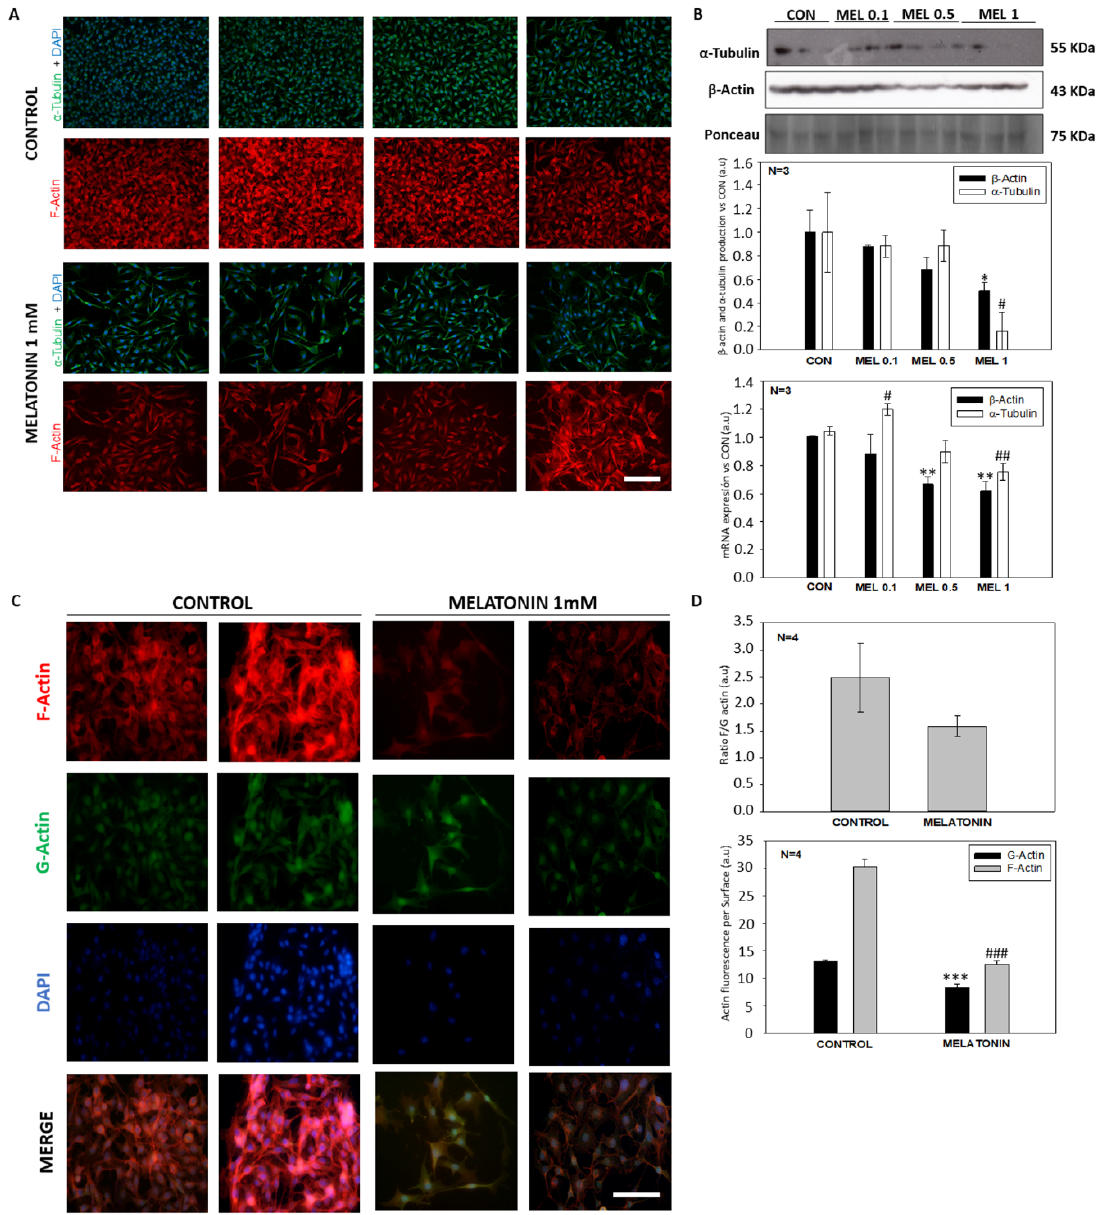
Figure 4. Cytoskeleton arrangement of B16-F10 cells treated with melatonin. ( A ) Fluorescence images of α -tubulin and β -actin location in control and treated cells. ( B ) Western blot and qPCR analysis of protein and mRNA levels of α -tubulin and β -actin. ( C ) Fluorescence images of G and F actin in control and treated cells. ( D ) Quantification of ratio between F and G actin and fluorescence level of both proteins. Significance vs. β -Actin CON. * p < 0.05, ** p < 0.01. Significance vs. α -Tubulin CON. # p < 0.05, ## p < 0.01. Significance vs. G-Actin CON. *** p < 0.001. Significance vs. F-Actin CON. ### p < 0.001. Image Scale bar = 100 µ m.